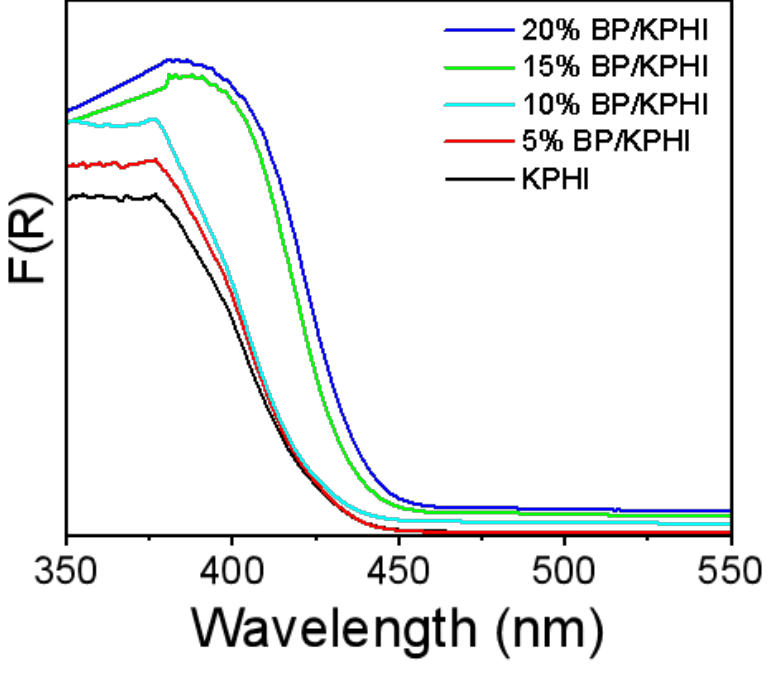
Figure 7. UV-vis DRS spectra of KPHI and KPHI/BP composite photocatalysts with different mass ratios.